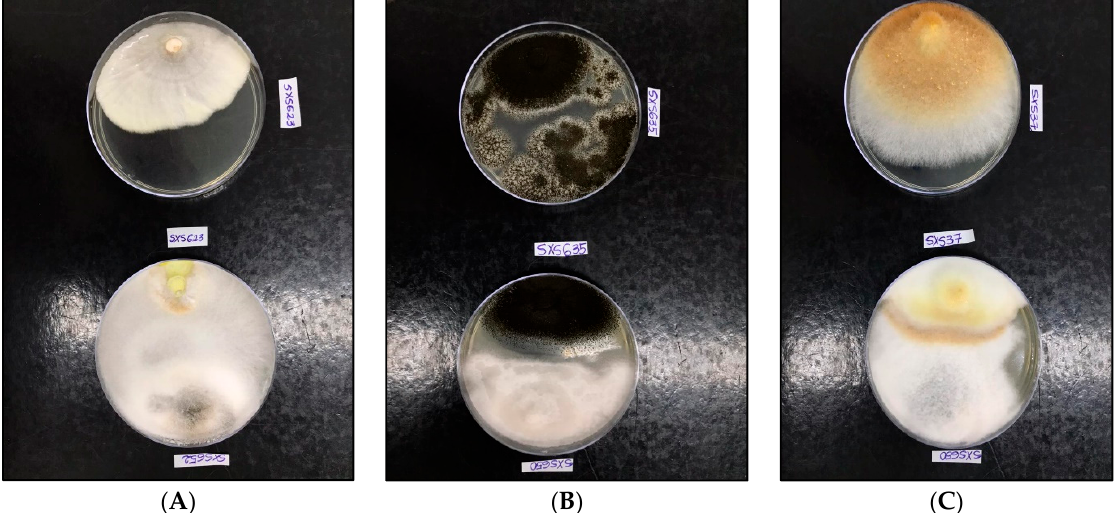
( A ) ( B ) ( C ) Figure 5. Paired culture test of endophytic fungi isolated from P. rigida Kunth against phytopathogenic fungi at 14 days of incubation. The plates arranged in the upper row correspond to the control and in the lower row to the test. ( A ): Above C. puteana SXS623 and below the same fungus × Diaporthe sp. SXS652 (PI 76.93%). ( B ): Above A. niger SXS635 and below the same fungus × Pestalotiopsis sp. SXS650 (PI 59.25%). ( C ): Above I. rickii SXS37 and below the same fungus × Pestalotiopsis sp. SXS650 (PI 57.14%). Table 6. Toxicity of extracts of endophytic fungi Colletotrichum sp. SXS649, Pestalotiopsis sp. SXS650, Botryosphaeriales SXS651, and Diaporthe sp. SXS652 isolates of P. rigida Kunth against A. salina using the Probit dose ‒ response methodology through the Statplus program. Values correspond to the mean of the triplicates ± standard deviation. Fungal Extract